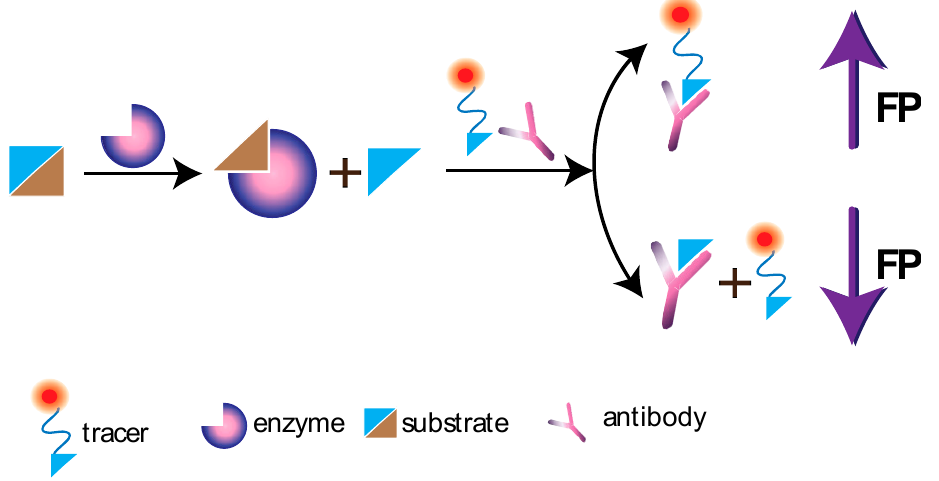
Figure 8. Principle of the using FP to determine enzymatic activity.